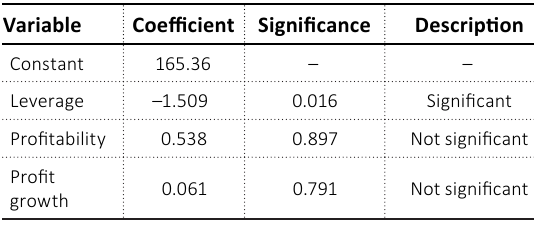
Table 5. Results of multiple linear regression